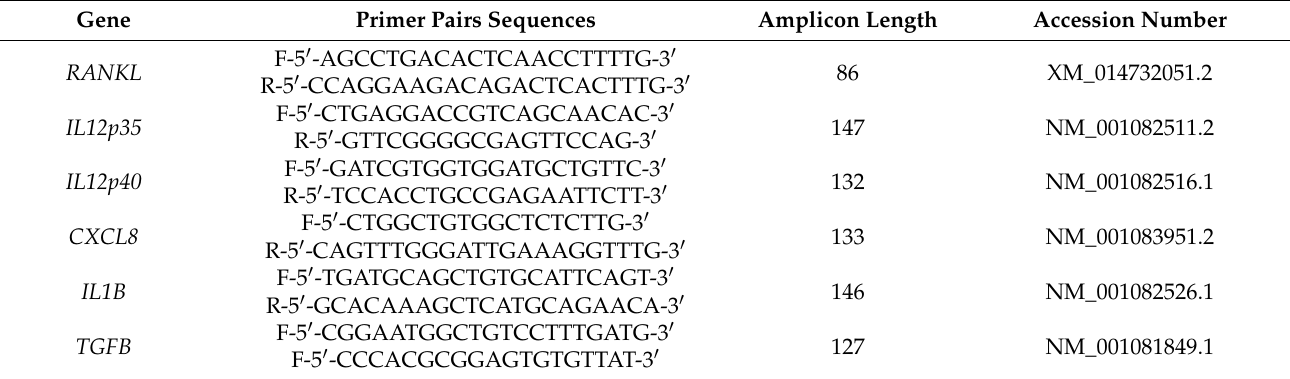
Table 2. Primer sets for gene expression